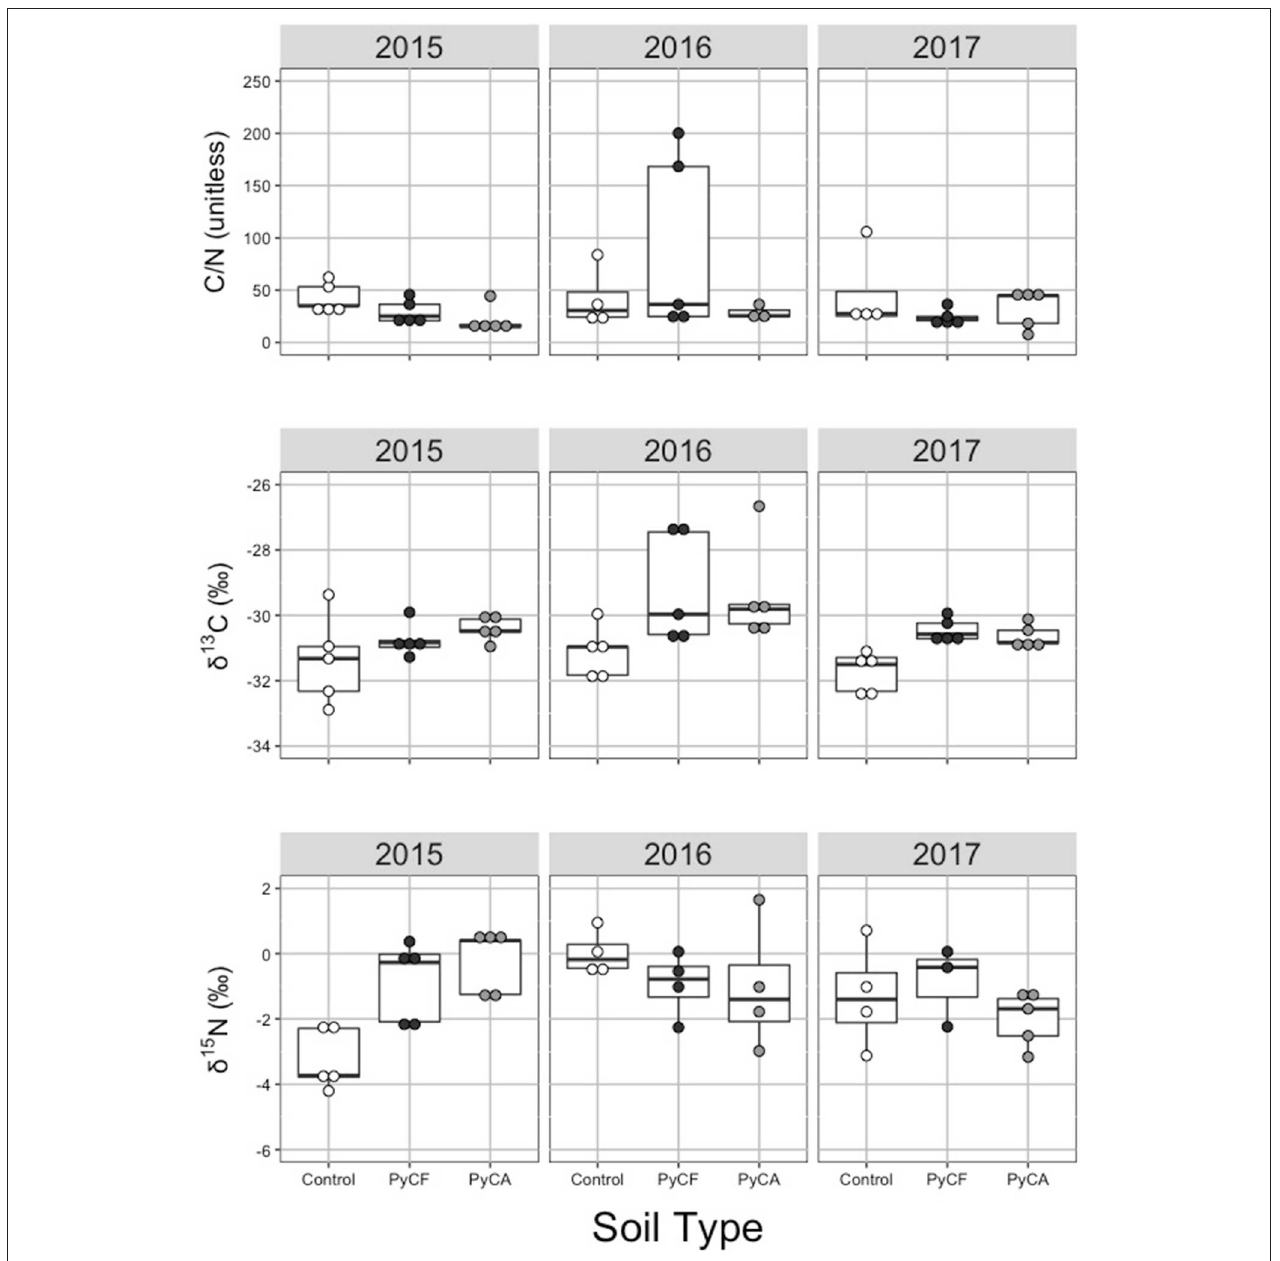
FIGURE 4 | Dot and box plots of leaf carbon to nitrogen ratios (C/N; top), 13 C discrimination ( δ 13 C; middle), and 15 N discrimination ( δ 15 N; bottom) for soil-less media controls (white dots) and media amended with forest (PyCF; dark gray dots) and recycled feedstock (PyCA; light gray dots) pyrogenic carbon in 2015, 2016, and 2017. Statistical results can be found in Table 3